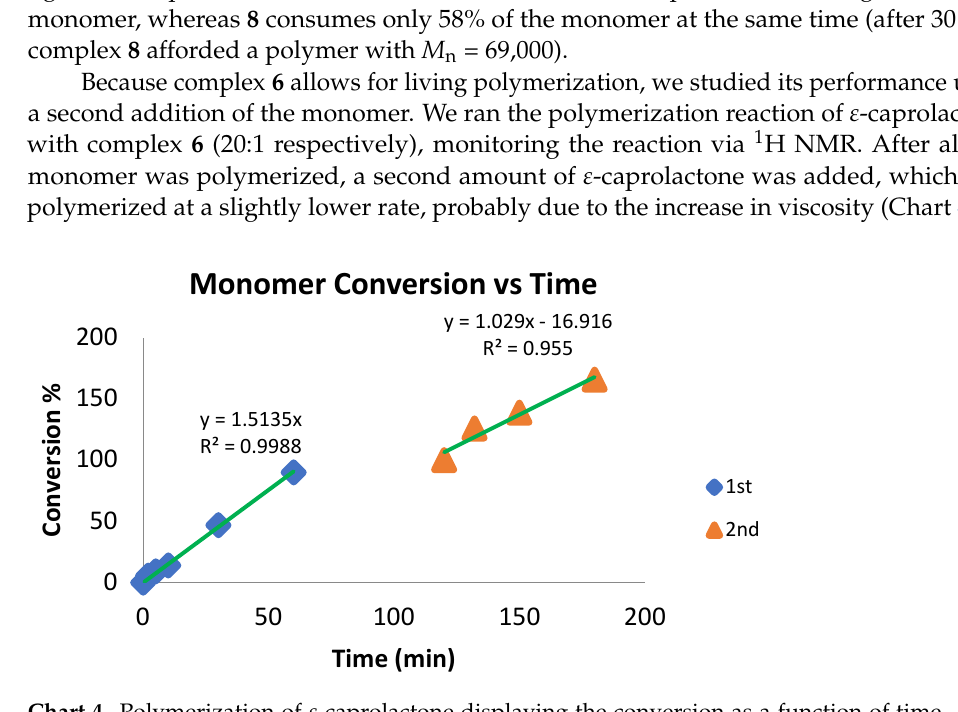
Chart 4. Polymerization of ε -caprolactone displaying the conversion as a function of time. After reaching 100% yield, an equal amount of ε -caprolactone was added. Conditions: 5 mL of toluene, r.t, 35 µ mol of catalyst 6 . Cat: ε -caprolactone; 1:20 for the first and second additions. The yield was determined by 1 H NMR spectroscopy of the crude reaction. Table 4. Polymerization results for the ROP of ε -caprolactone mediated by complexes 4 – 6 . Complex